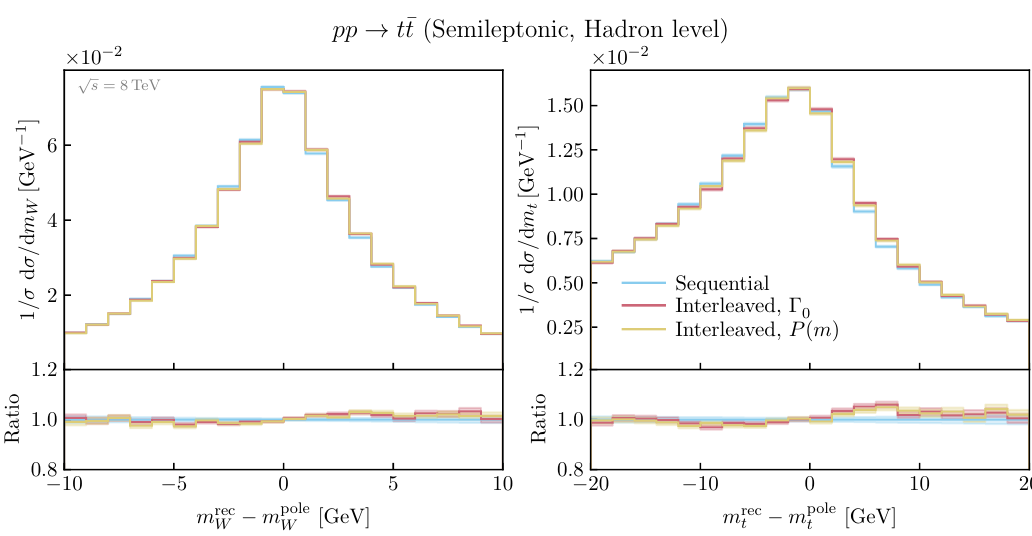
Figure 11: Difference between the reconstructed and the pole masses of hadronically decaying W bosons (left) and top quarks (right), in semi-leptonic pp → t ¯ t events at (cid:112) s =